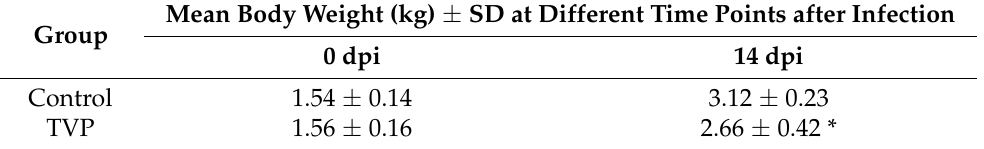
Table 1. Mean body weight of birds in transmissible viral proventriculitis (TVP) and Control groups.